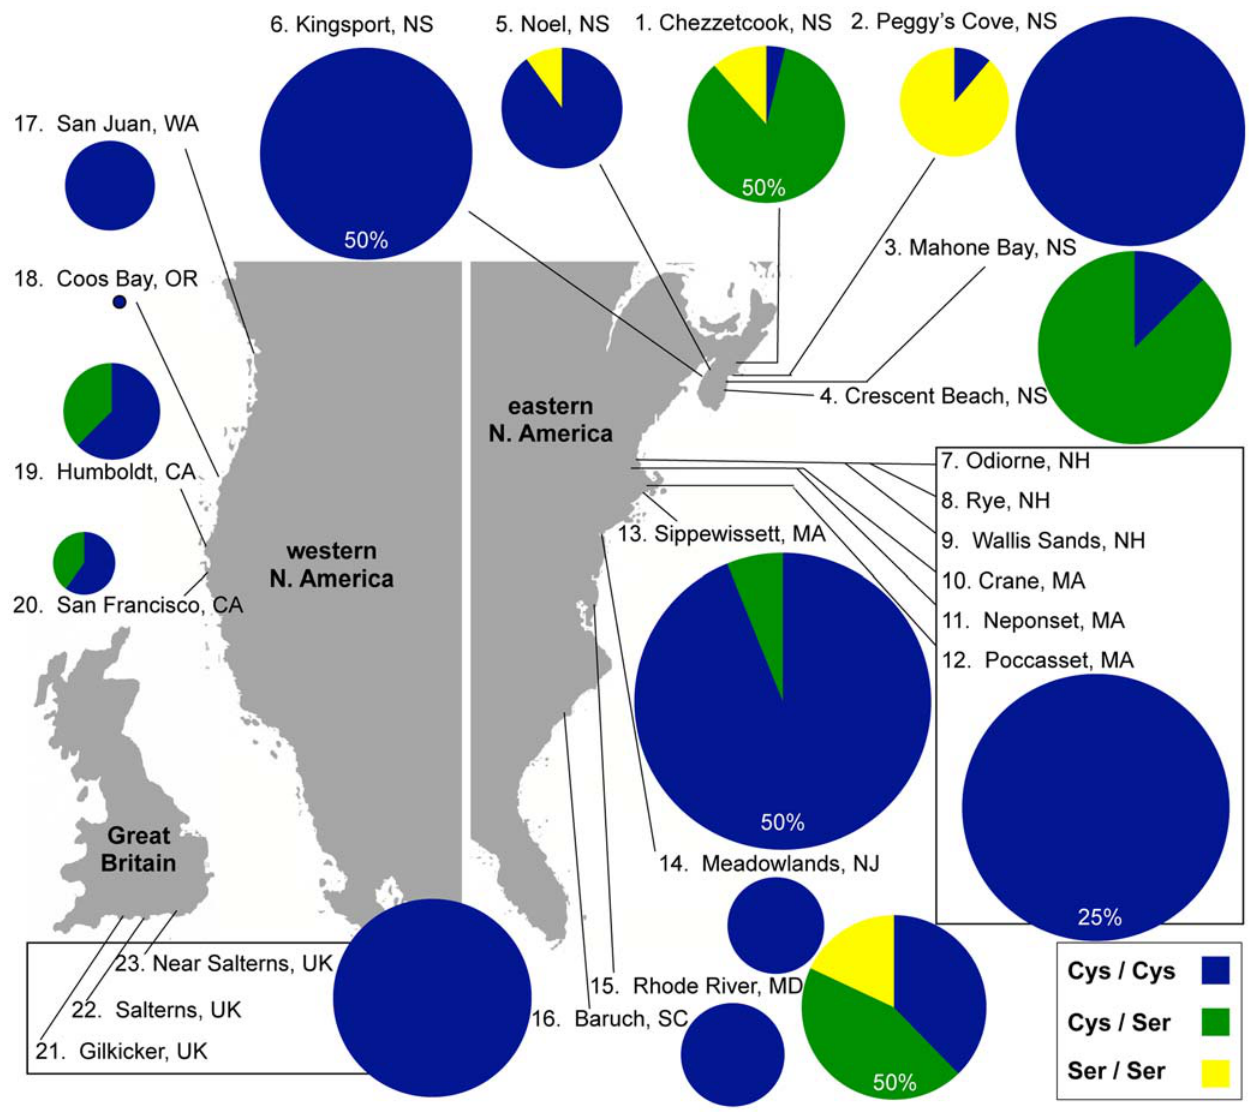
Figure 5. Geographical distribution of Cys (C1-C4) and Ser NF- k B genotypes. Pie graphs display the frequency of each genotype within the indicated populations (see Table 1 for details). The area of each graph reflects the relative sample size from that locale; for the large samples obtained at Chezzetcook (population 1), Kingsport (6), Sippewisset (13), and Rhode River (15), and the samples pooled from northern New England (7–12), the pie graphs are depicted at 50% or 25% of their relative size (as indicated on each graph). Populations 7–12 were grouped and populations 21–23 were grouped because the individual sites within each group are in close geographical proximity, and the groups exhibit no genotypic variability. The most abundant genotype, Cys/Cys, was found in every estuary sampled. With the exception of a few Ser/Ser individuals found in the lab population derived from Rhode River, Maryland, Ser/Ser homozygotes are restricted to Nova Scotia.